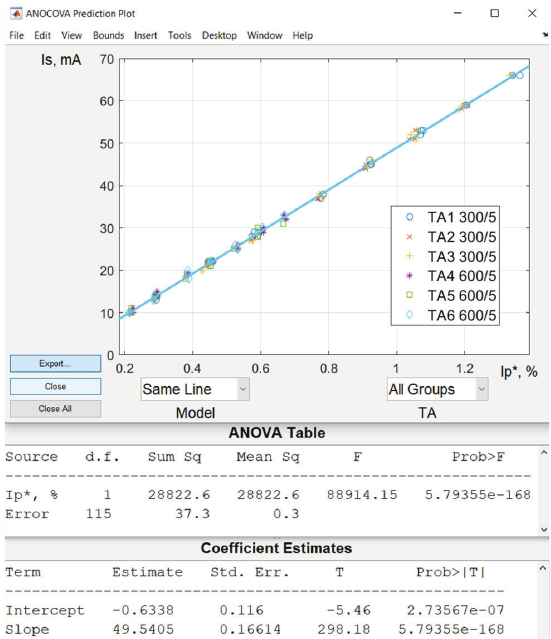
Fig. 2. The results of graphic tool for analysis of covariance usage: linear regression describing the dependence of the secondary current I s (mA), according to the readings of the transformer connected meter, on the relative value of the primary current * according to the readings of the directly connected meter,